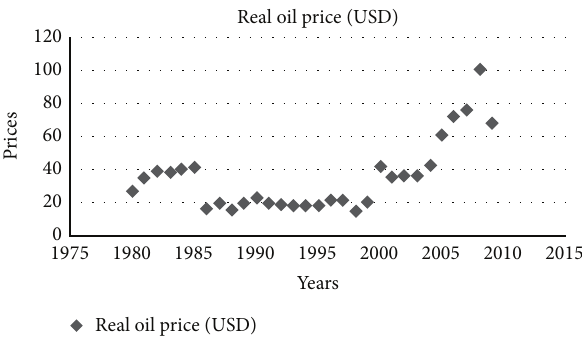
Figure 1: Annual carbon intensity levels.